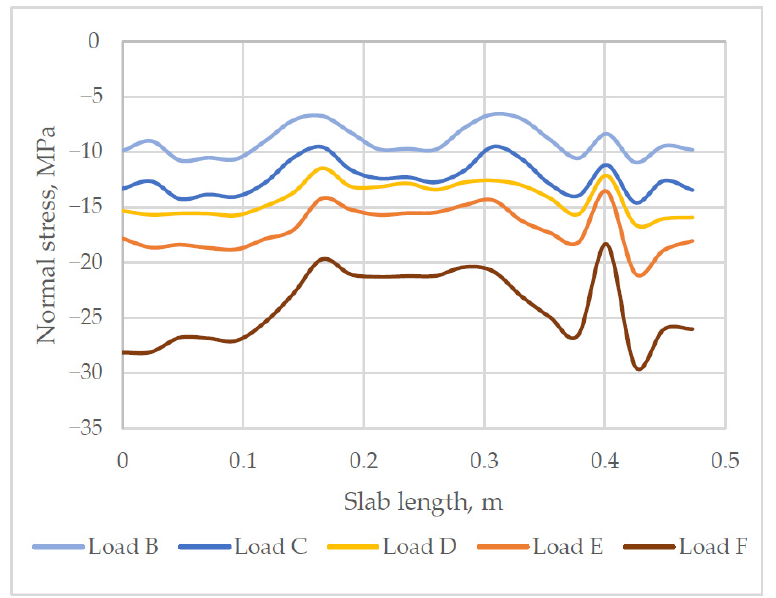
Figure 15. Normal stress distribution over the length of the cross-section (negative stress values = Figure compression).